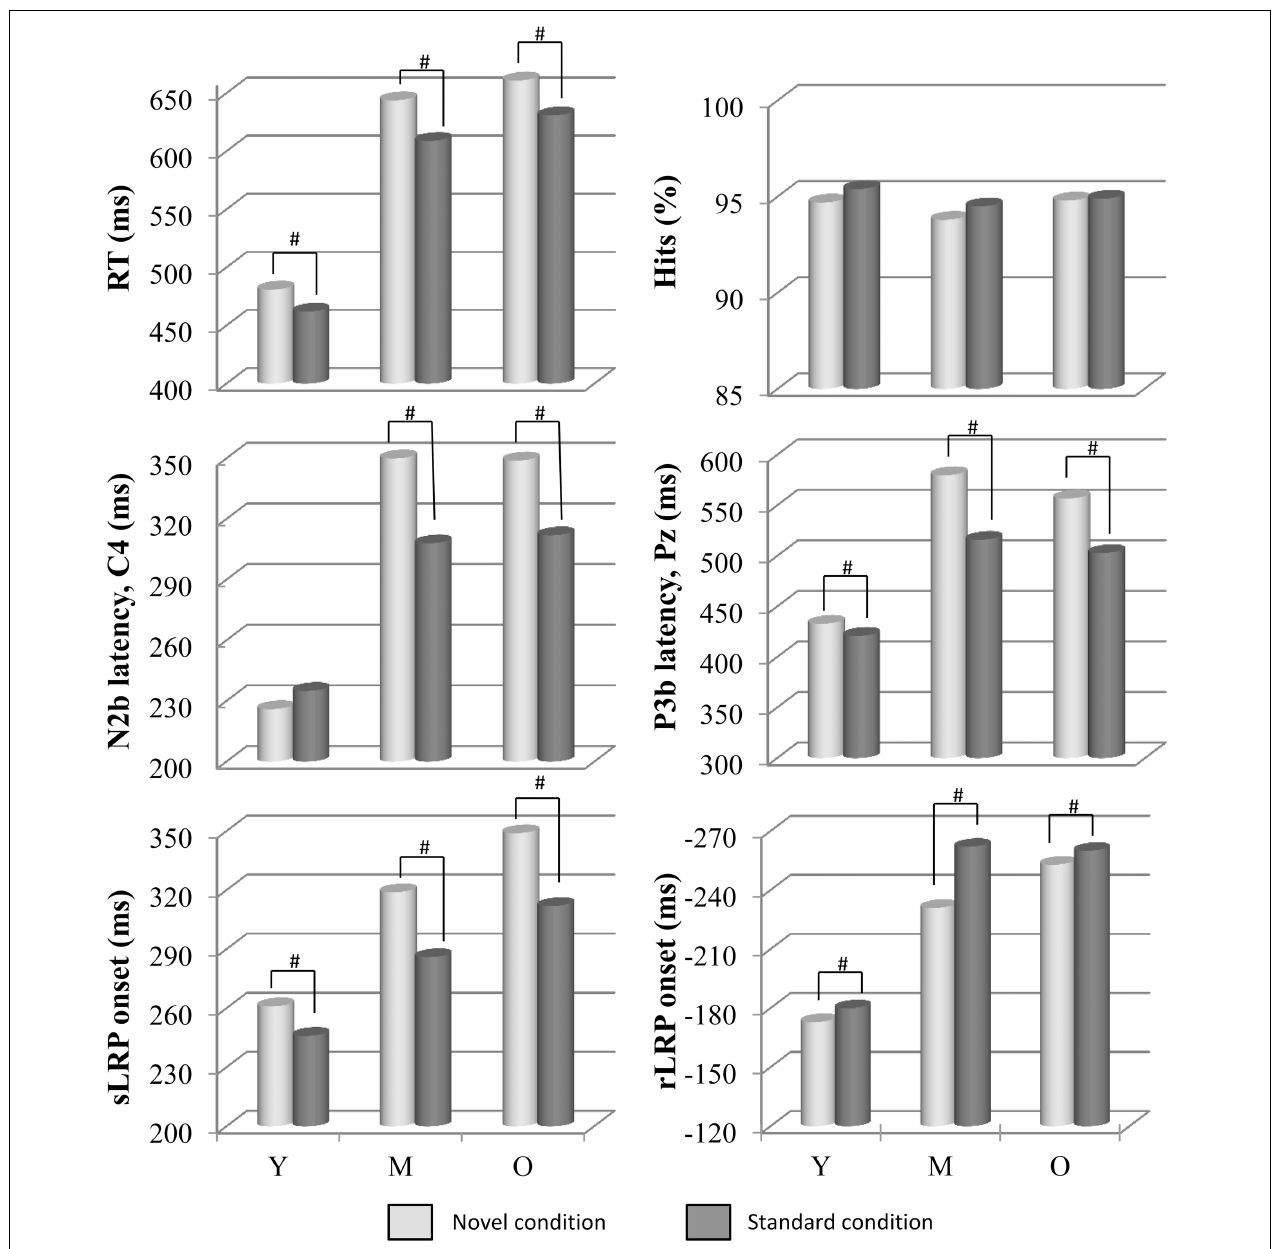
FIGURE 1 | Mean values of RT, N2b (at C4) and P3b (at Pz) latencies, sLRP and rLRP onset latencies (in ms), and percentage of hits, in each condition (novel and standard) and in each age group (Y, young; M, middle-aged; and O, old). Distraction effect caused by novel stimuli, respect to standard stimuli, was associated with longer RT, N2b, and P3b latencies, and sLRP onset latency. For N2b latency at C4 and C3